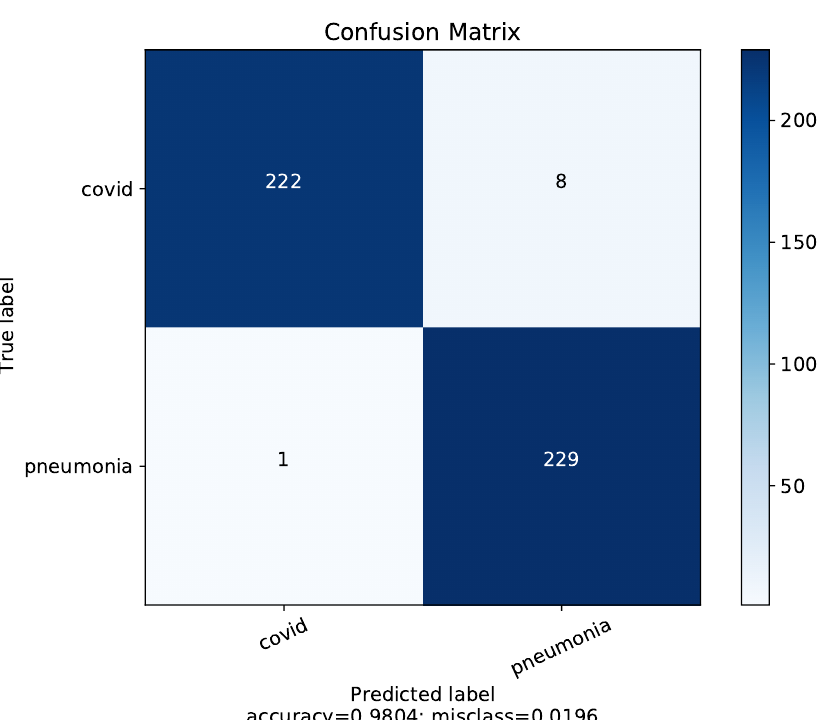
Figure 11. Confusion matrix on fold-5 of